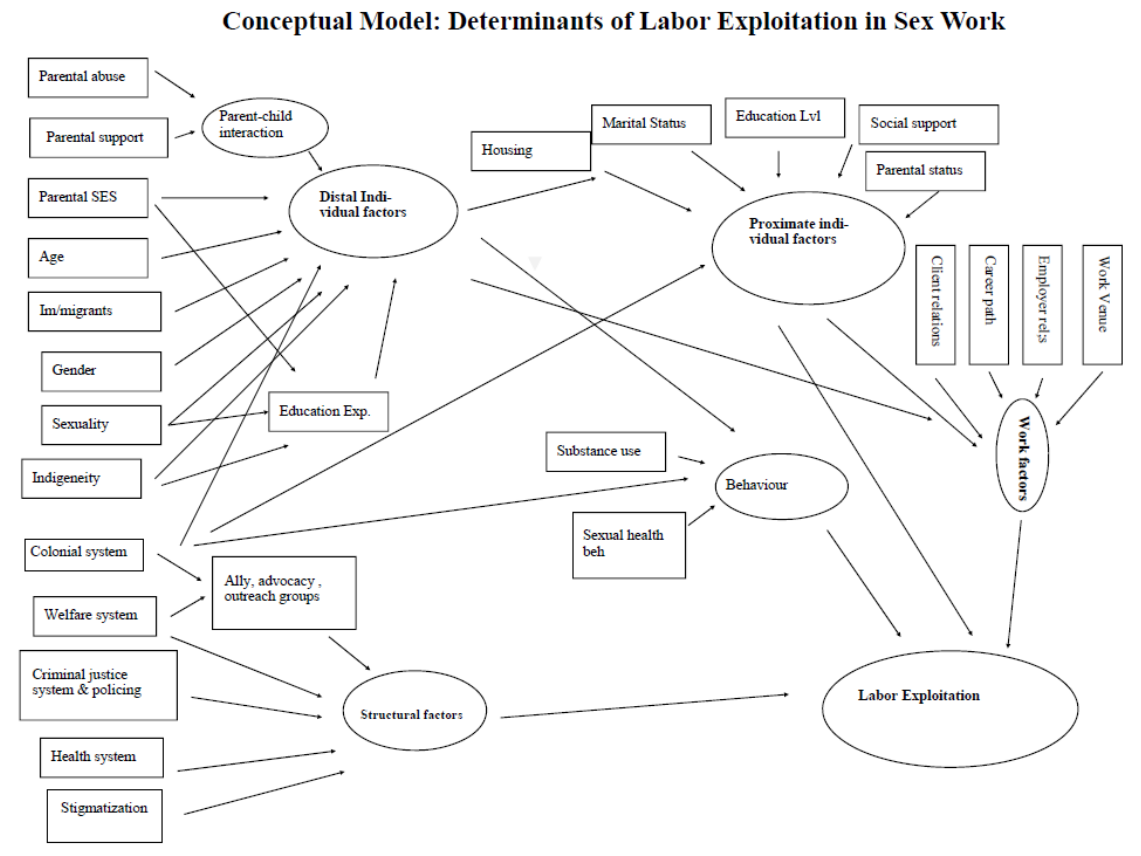
Figure 1. Determinants of Labor Exploitation in Sex Work.